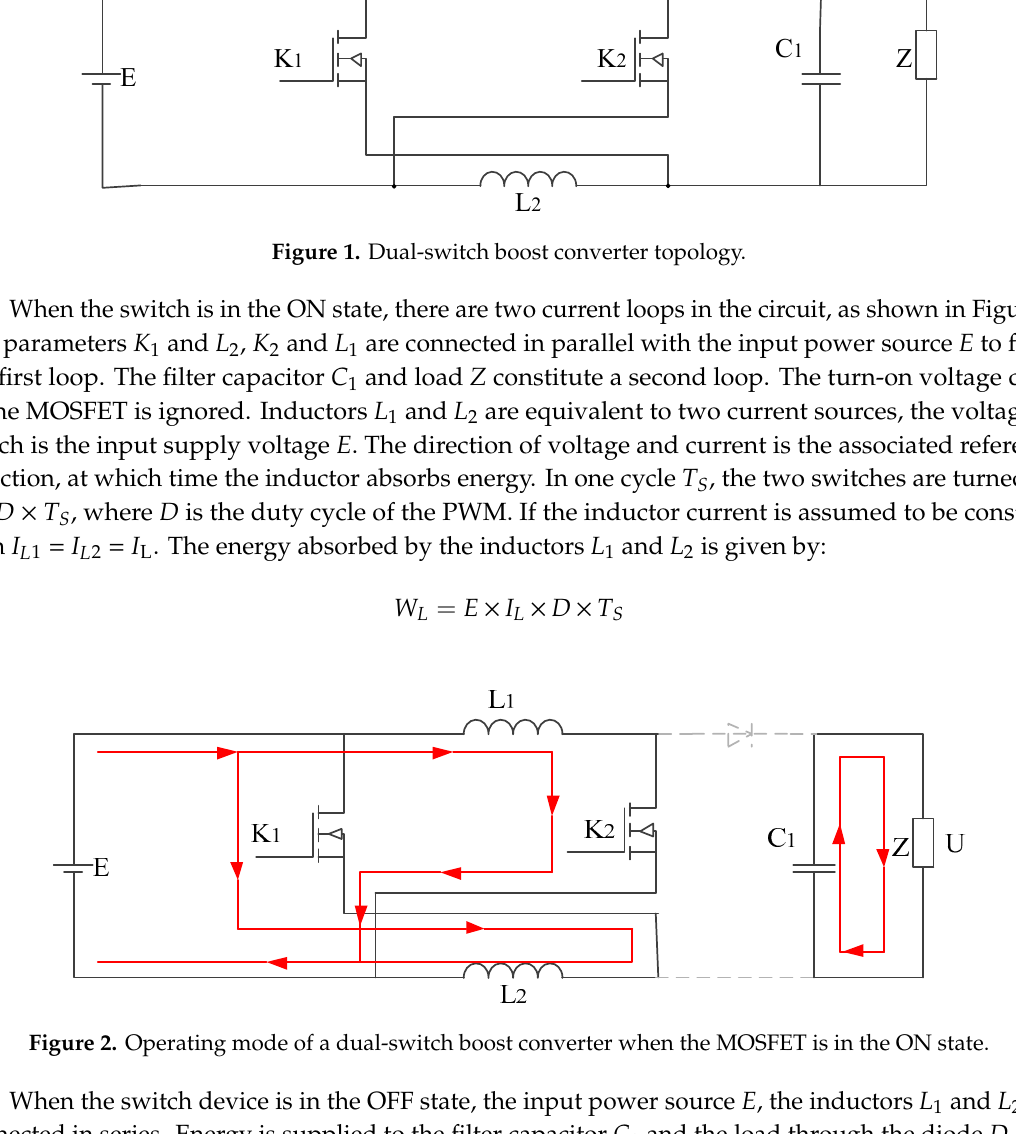
Figure 2. Operating mode of a dual-switch boost converter when the MOSFET is in the ON state.